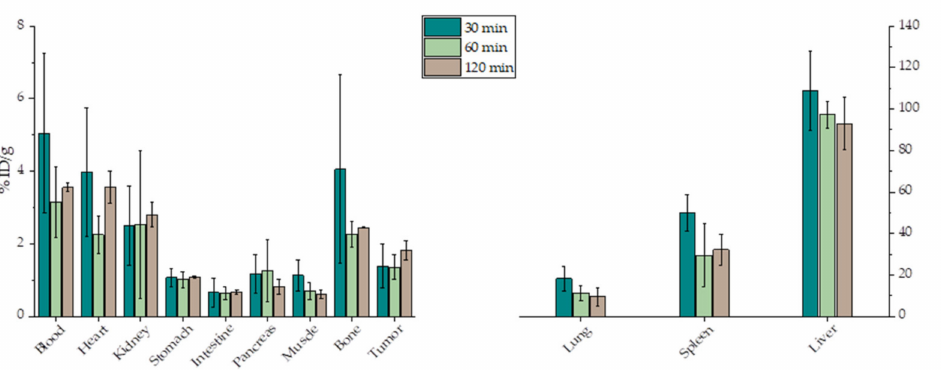
Figure 11. Biodistribution of [ 68 Ga]Ga-MagP-NODAGA MIONs in SCID mice bearing 4T1 tumors ( n = 3–5 mice per time point). Absence of asterisks denotes a nonsignificant statistical difference.